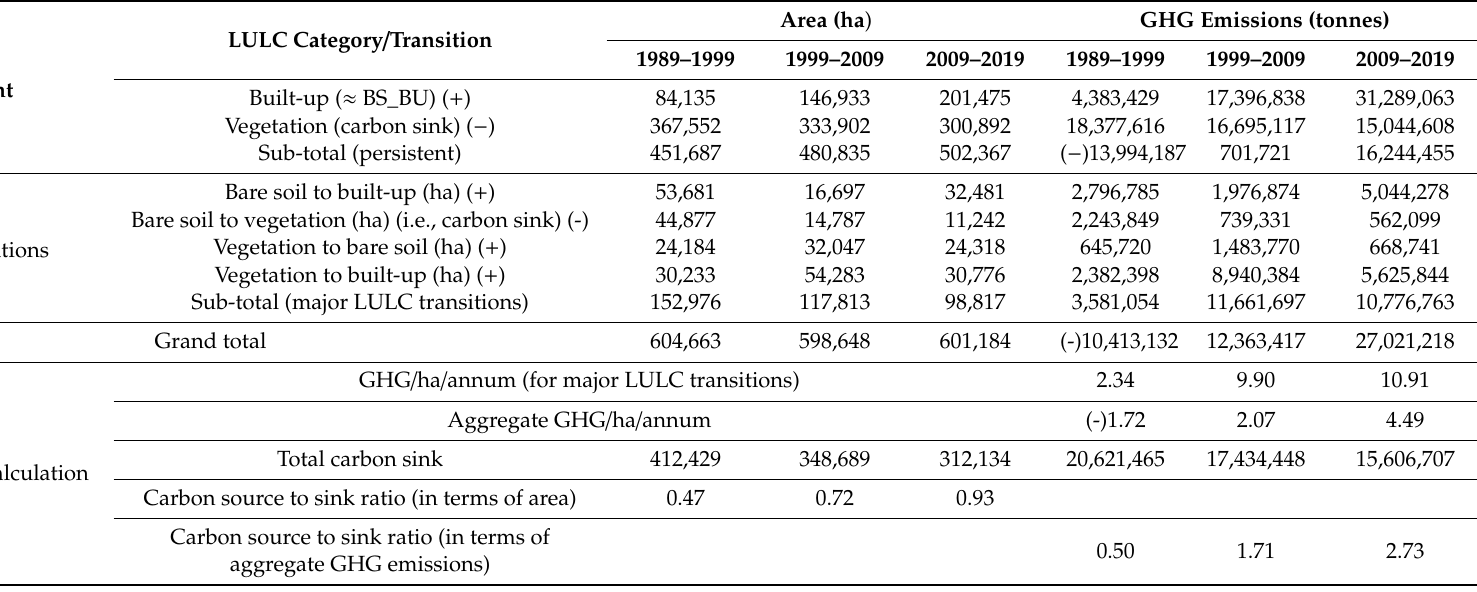
Table 9. Calculating aggregate GHG emissions in the study